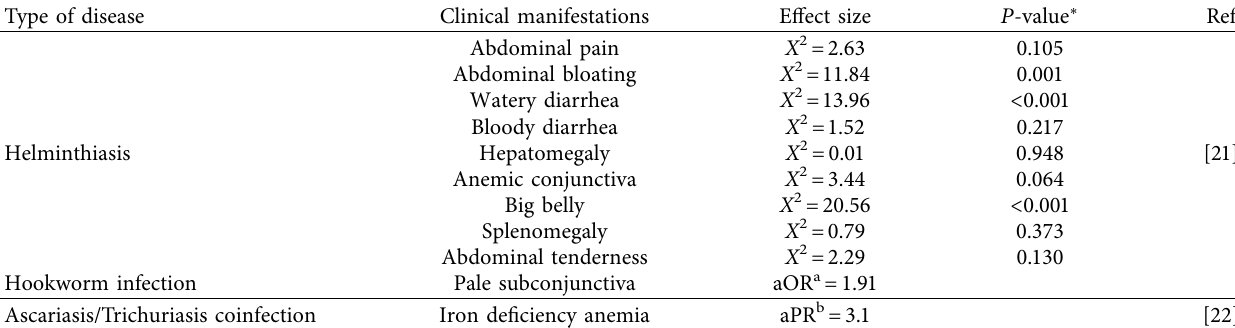
Table 3: Summary of clinical manifestations in various studies.